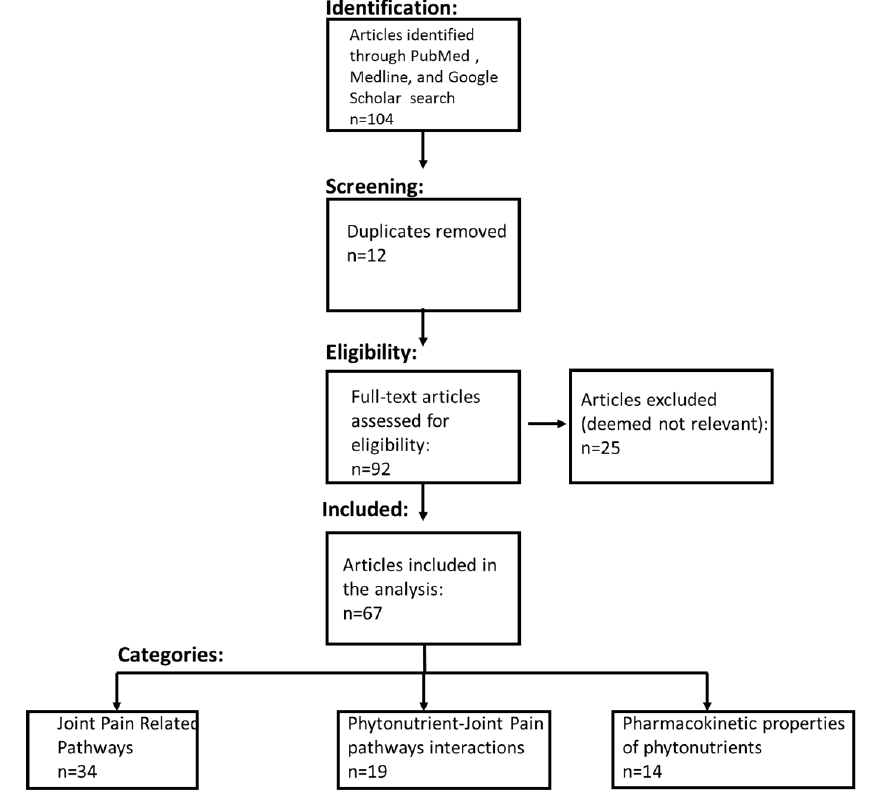
Figure 1. PRISMA flow diagram. The systematic literature review process included identifying the relevant literature from PubMed, Medline, and Google Scholar. The literature was then filtered to remove duplicate studies. The eligibility of articles for the comprehensive review was determined using the inclusion criteria detailed in the Materials and Methods section.